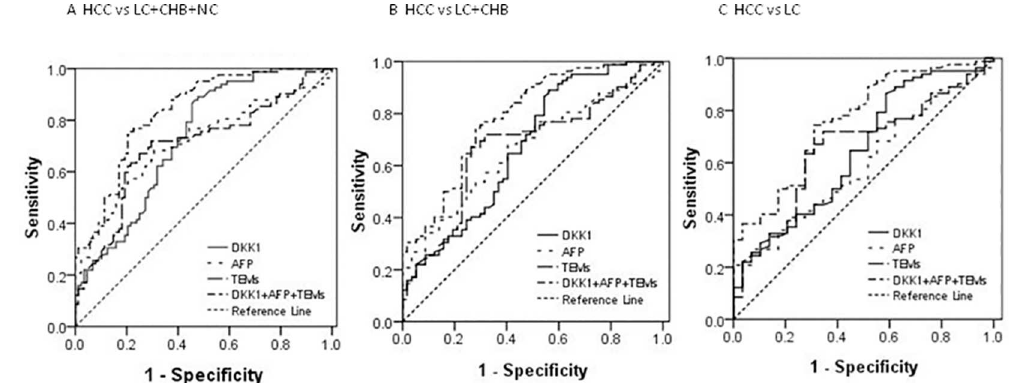
Fig 2. ROC curves for DKK1, TEMs, AFP and Logit P 1 for the diagnosis of HCC versus different cohorts. ( A) ROC curves for DKK1, TEMs, AFP and Logit P 1 for the diagnosis of HCC versus all controls, with an AUC value of 0.728, 0.701, 0.712 and 0.833 respectively.(B) ROC curves for DKK1, TEMs, AFP and Logit P 1 for the diagnosisof HCC versus LC and CHB controls, with an AUC value of 0.673, 0.673, 0.664 and 0.789 respectively. (C) ROC curves for DKK1, TEMs, AFP and Logit P 1 for the diagnosis of HCC versus LC controls, with an AUC value of 0.644, 0.657, 0.592 and 0.762 respectively.ROC = receiver operatingcharacteristic. AUC = area under receiver operatingcharacteristic. HCC = hepatocellular carcinoma.CHB = chronichepatitisB virus infection. LC = liver cirrhosis. Logit P1 = -2.635+0.002 × DKK1+0.001 × AFP+0.147 × TEMs.